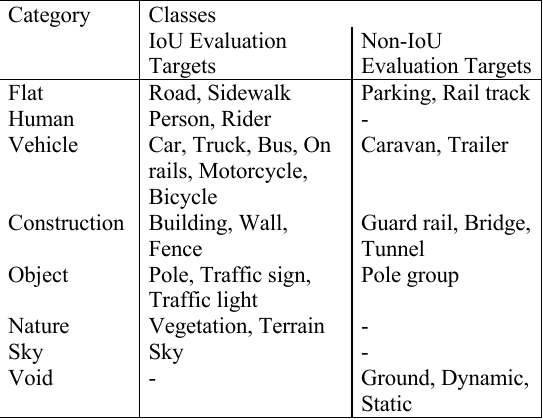
Table 1 . Landscape elements defined in Cityscapes